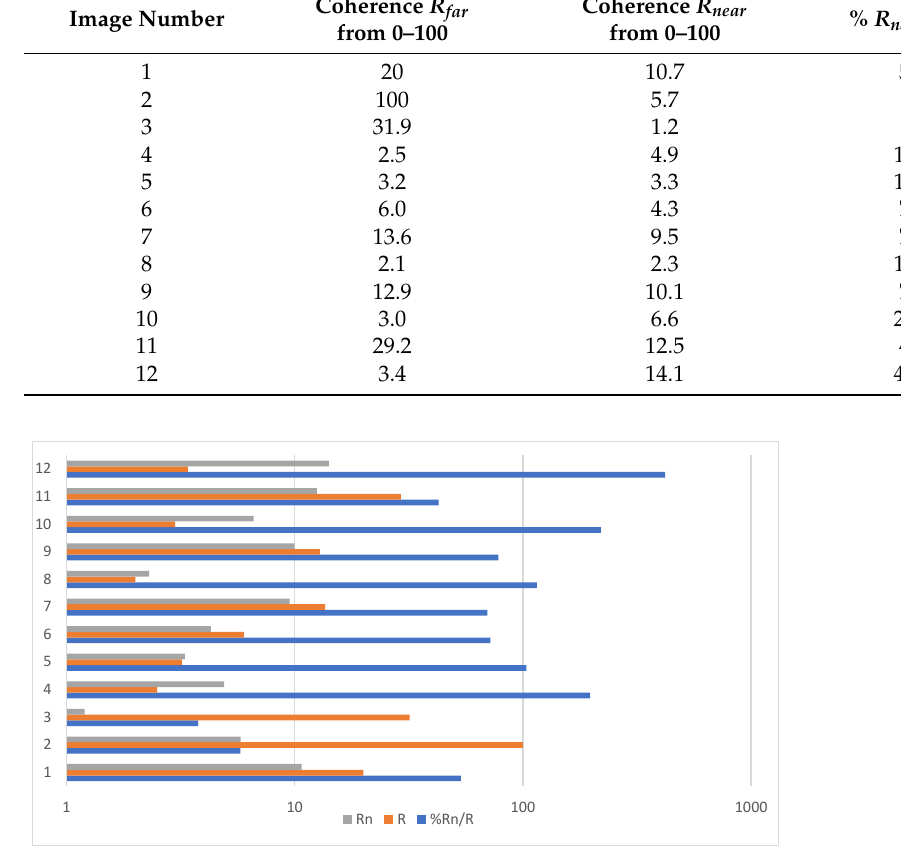
Figure 7. Histogram plot of the R n = R near , R = R far , and % R near / R far values computed from the images. The horizontal axis is presented in a logarithmic scale for clarity, as there is wide variation among the values.